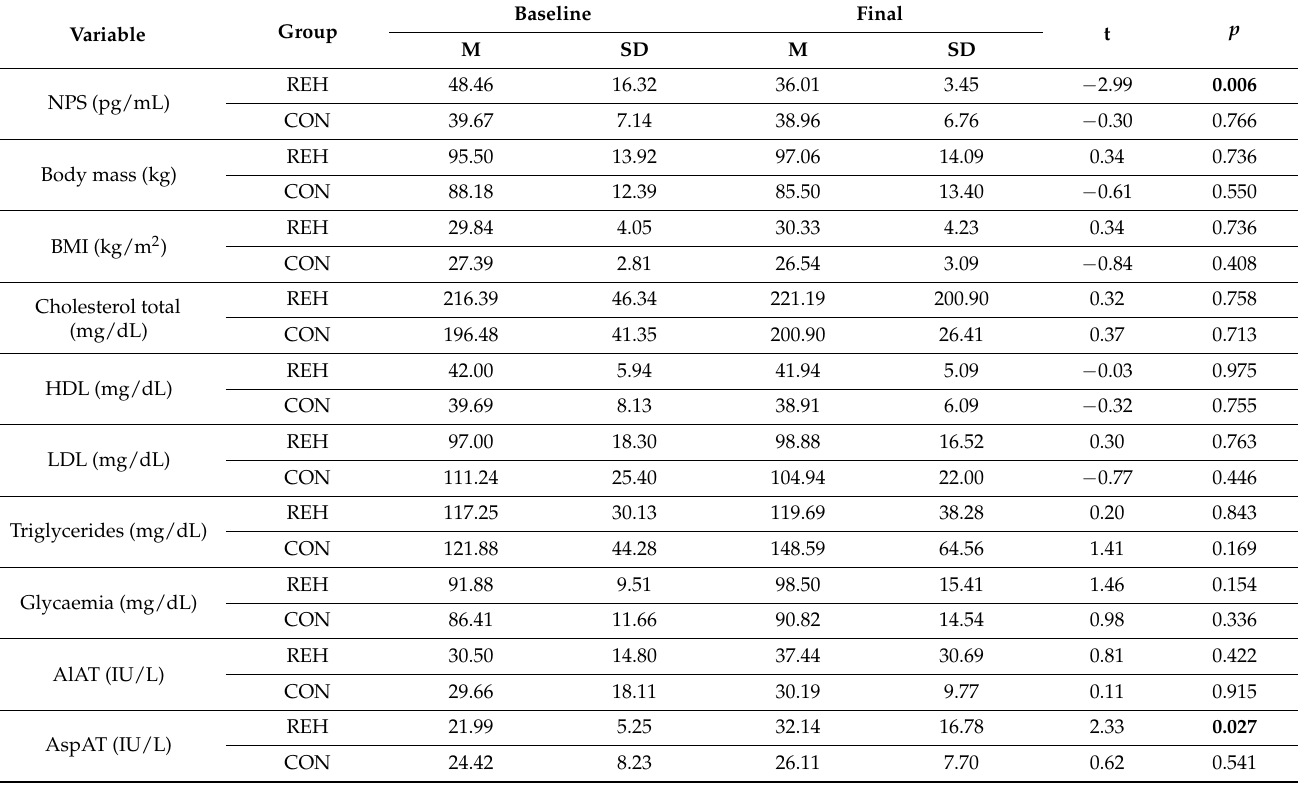
Table 3. T1 versus T2 results: NPS and metabolic